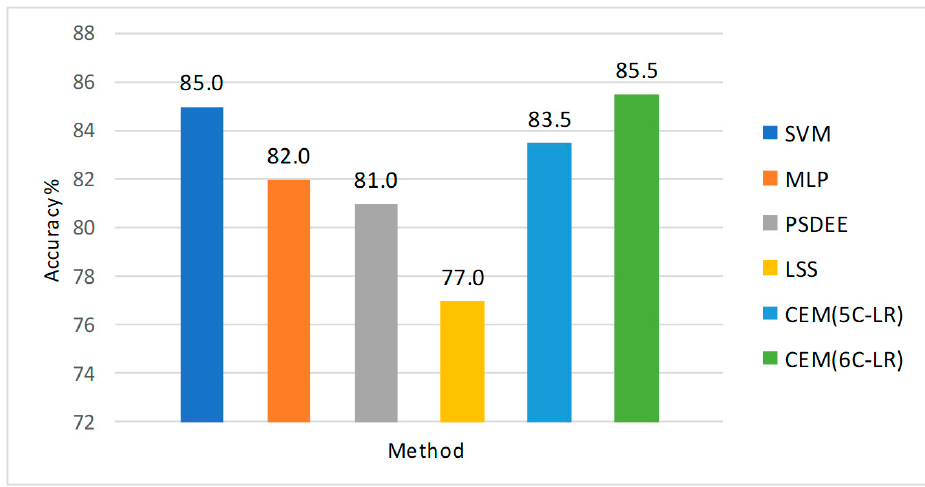
Figure 8. Results experimented on corpus DVD.